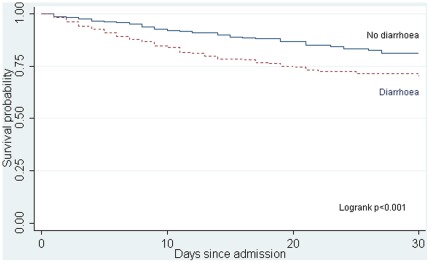
Kaplan-Meier plot of survival time of children with SAM admitted with and without diarrhoea.